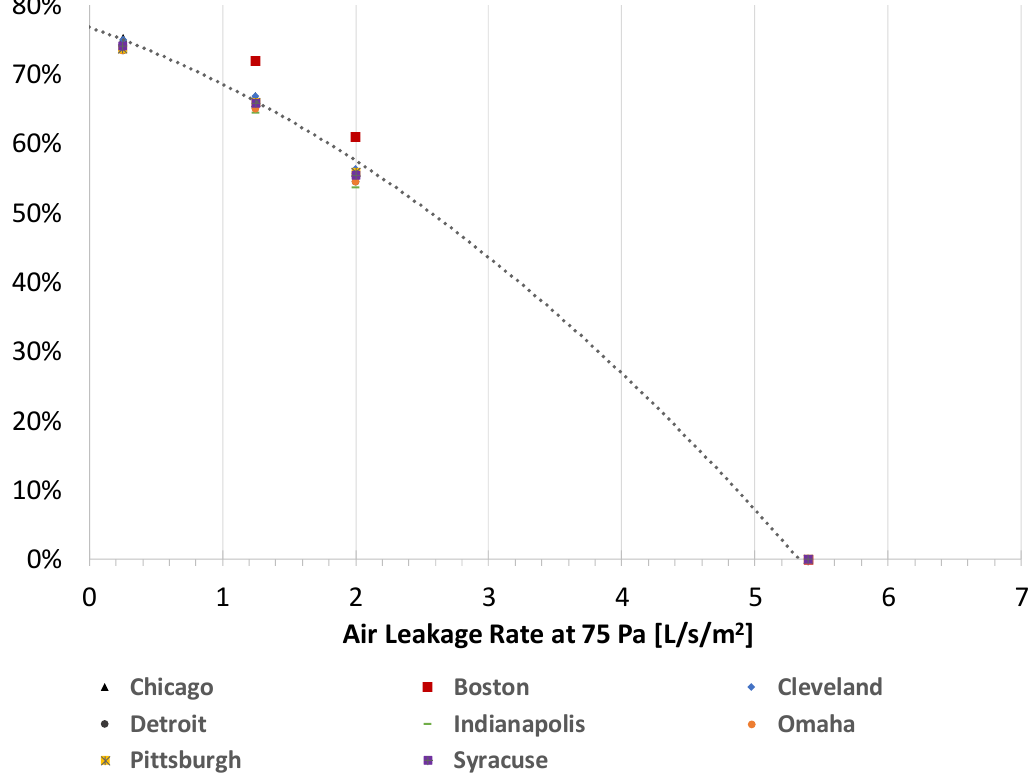
Figure 6. Annual relative heating energy savings due to increased airtightness in stand-alone retail prototype buildings in Climate zone 5A. The baseline leakage rate is 5.4 L/s/m 2 .